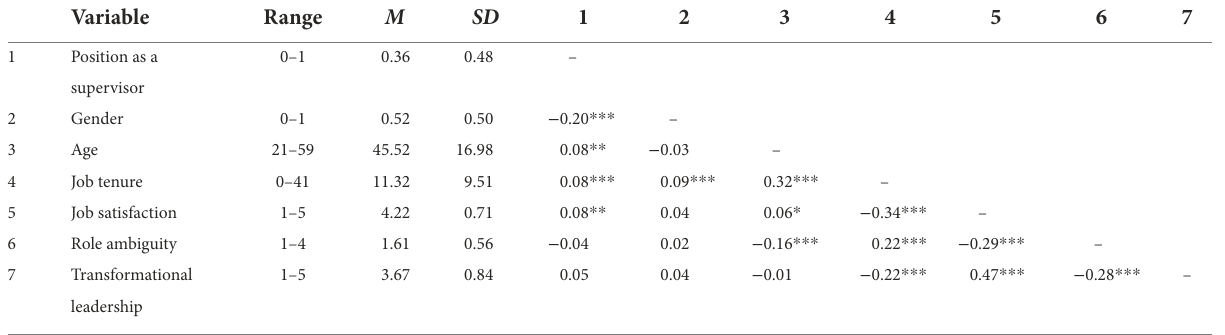
TABLE 3 Means, SD, and correlations for variables in Study 2.